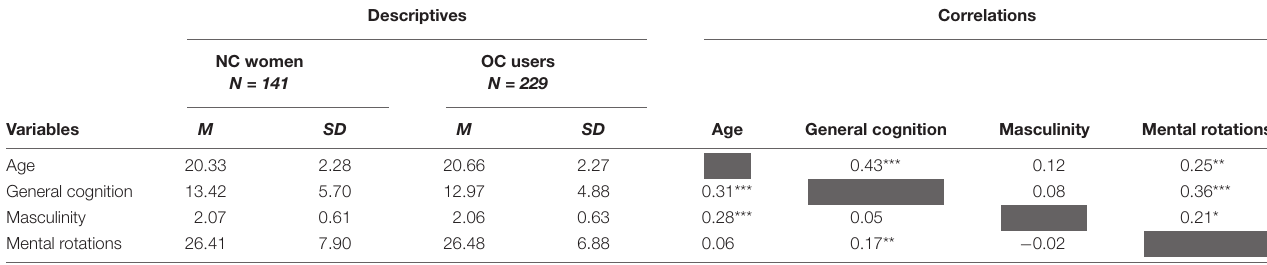
TABLE 1 | Descriptive statistics and correlations among study variables by